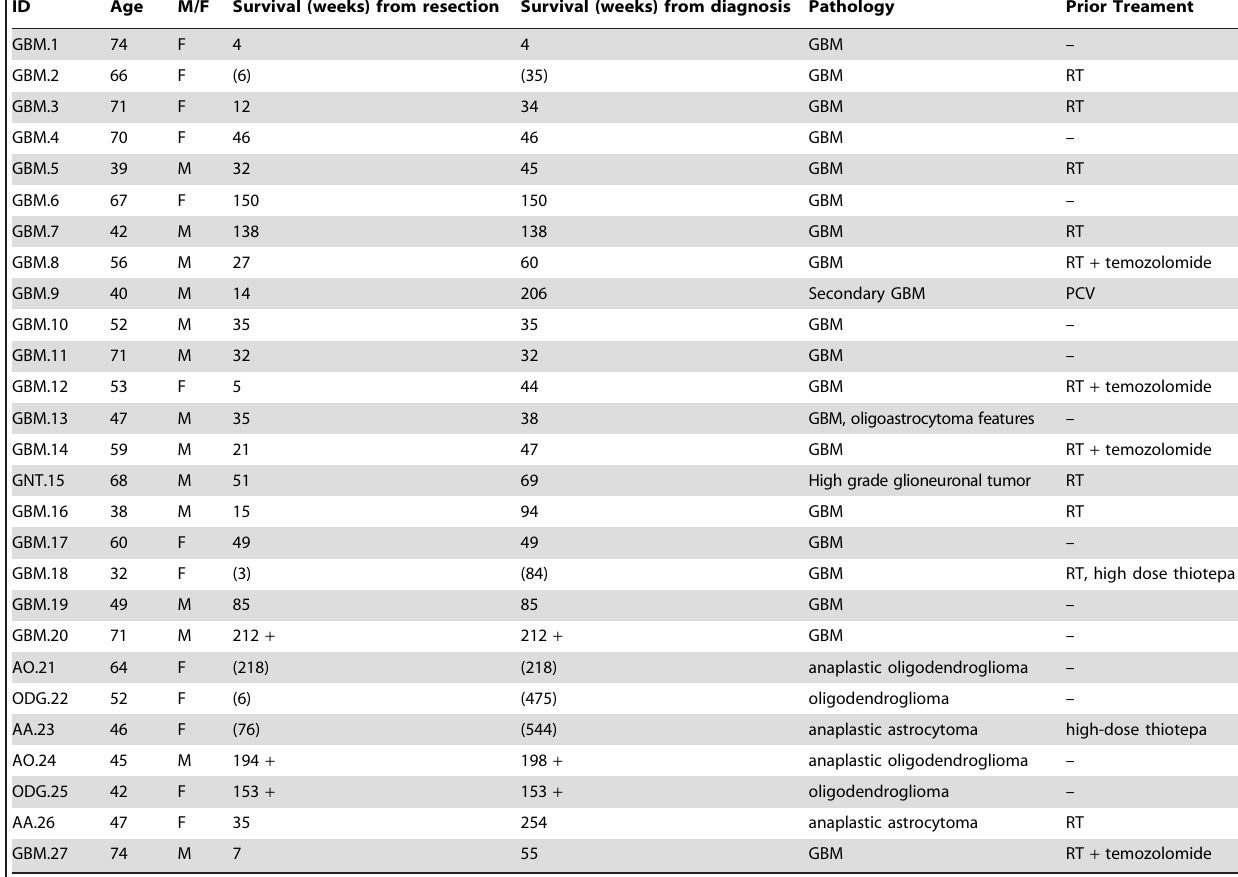
Table 1. Patient and tumor